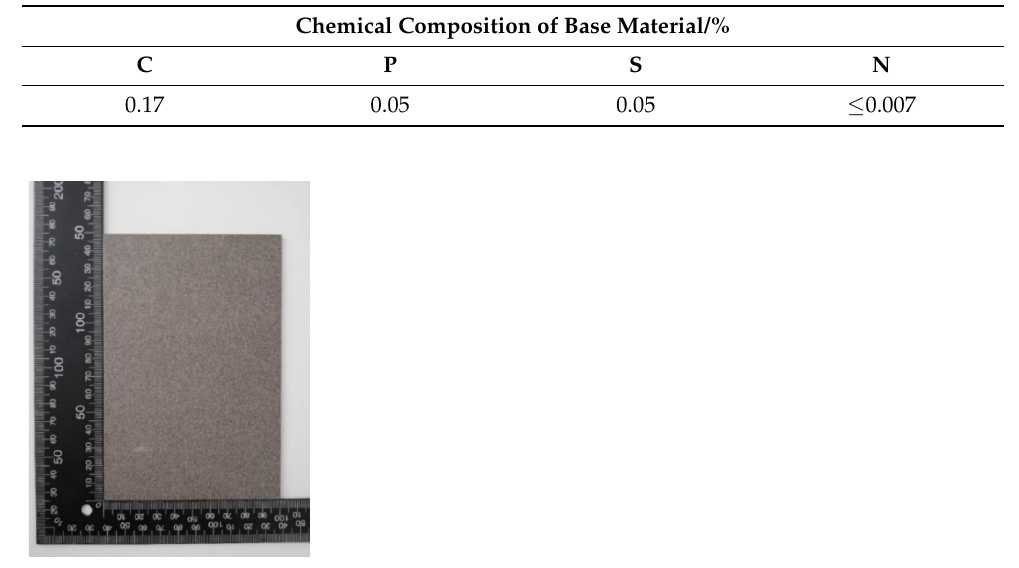
Table 3. Chemical composition of the base material [42].